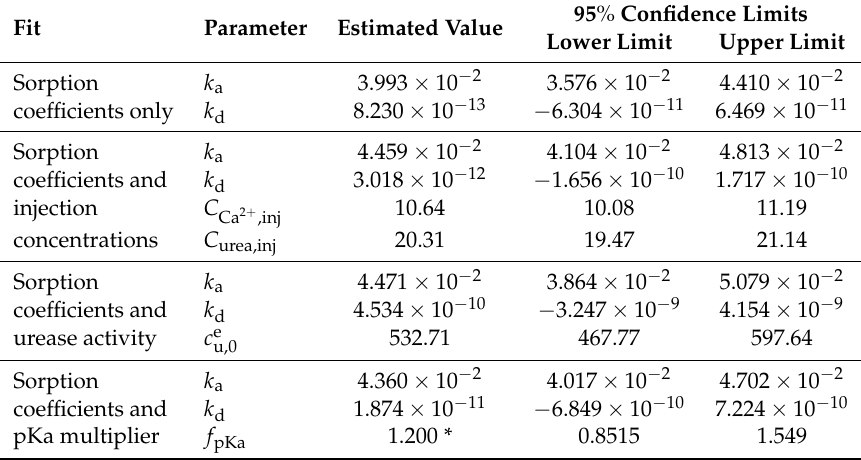
Table 1. Estimated parameter values and confidence intervals as given by the Model-Independent Parameter Estimation (PEST) protocol [58] for the four investigated sets of calibration parameters calibrating to the concentration measurements of column #1 (0.33